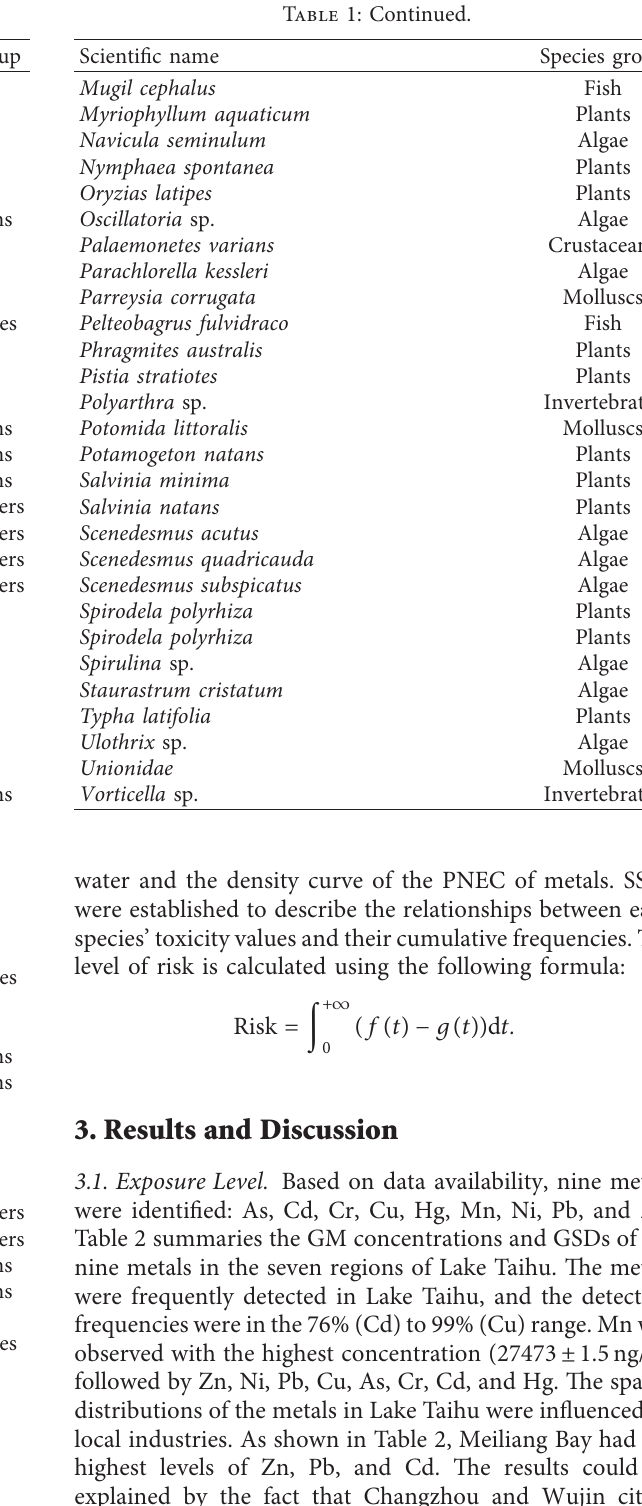
Table 1: Taihu species used for the ecotoxicity data.